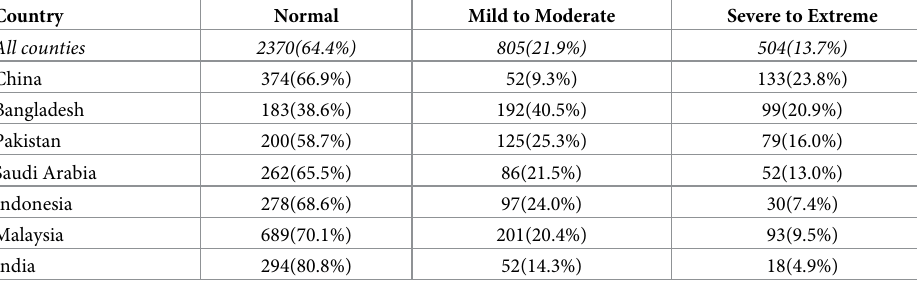
Table 2. Level of anxiety by